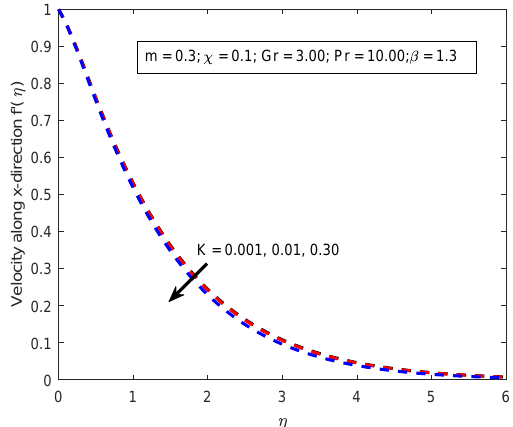
Figure 2: Variation of velocity in the x − direction with rotation pa- rameter